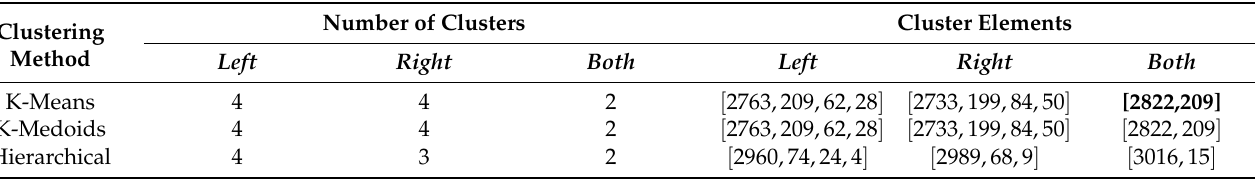
Table 4. Clustering results of each case with the Davies Bouldin index. The best results are indicated with bold.